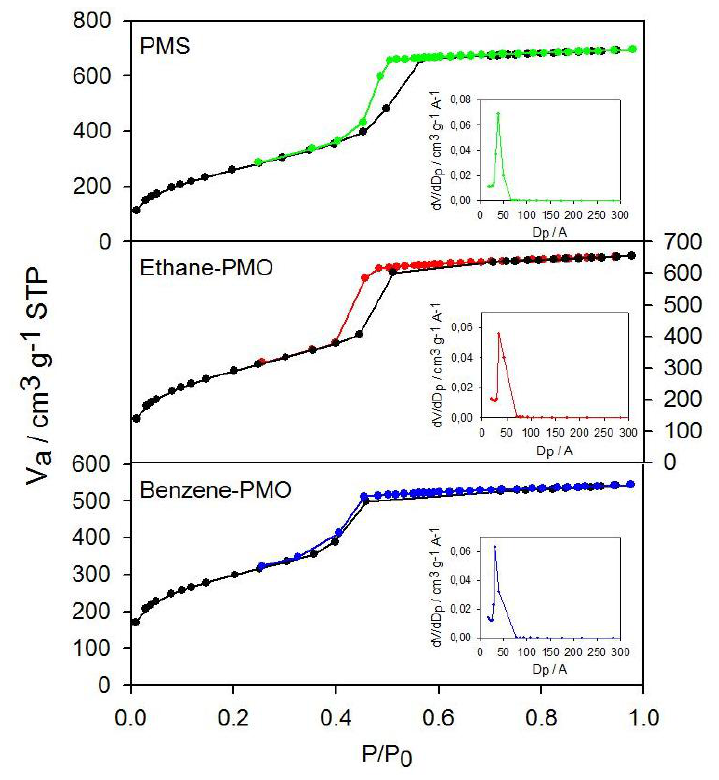
Figure 2. Nitrogen adsorption-desorption isotherms and pore size distribution curves (insets) of the mesoporous materials used as